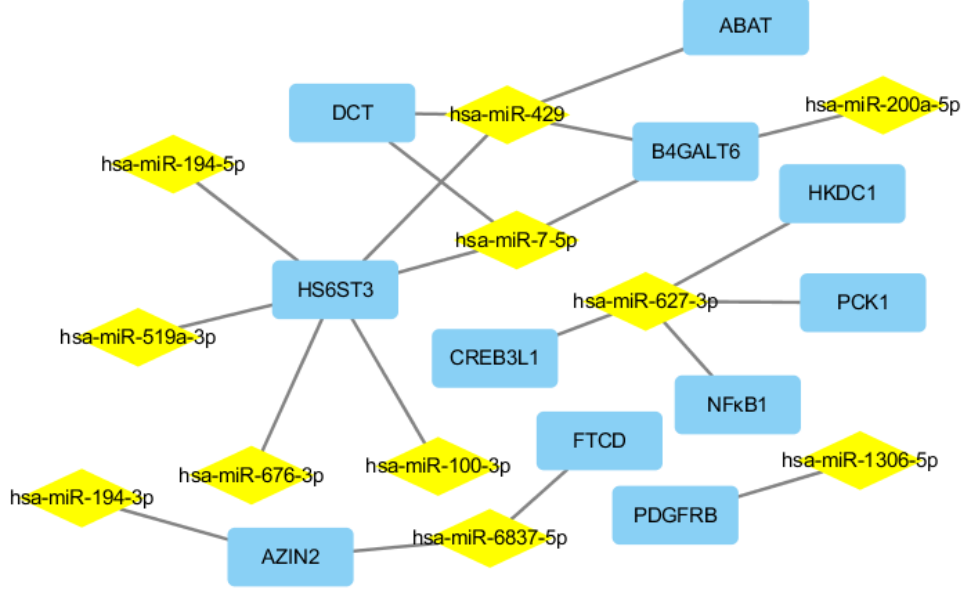
Figure 8. Putative miRNA–mRNA negative correlation network in response to naringenin. Rectangular nodes, mRNAs; diamond nodes, miRNAs.